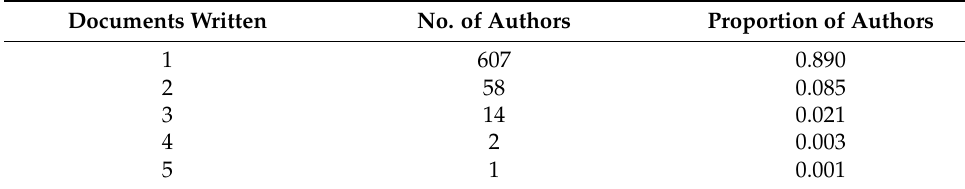
Table 7. Author impact.